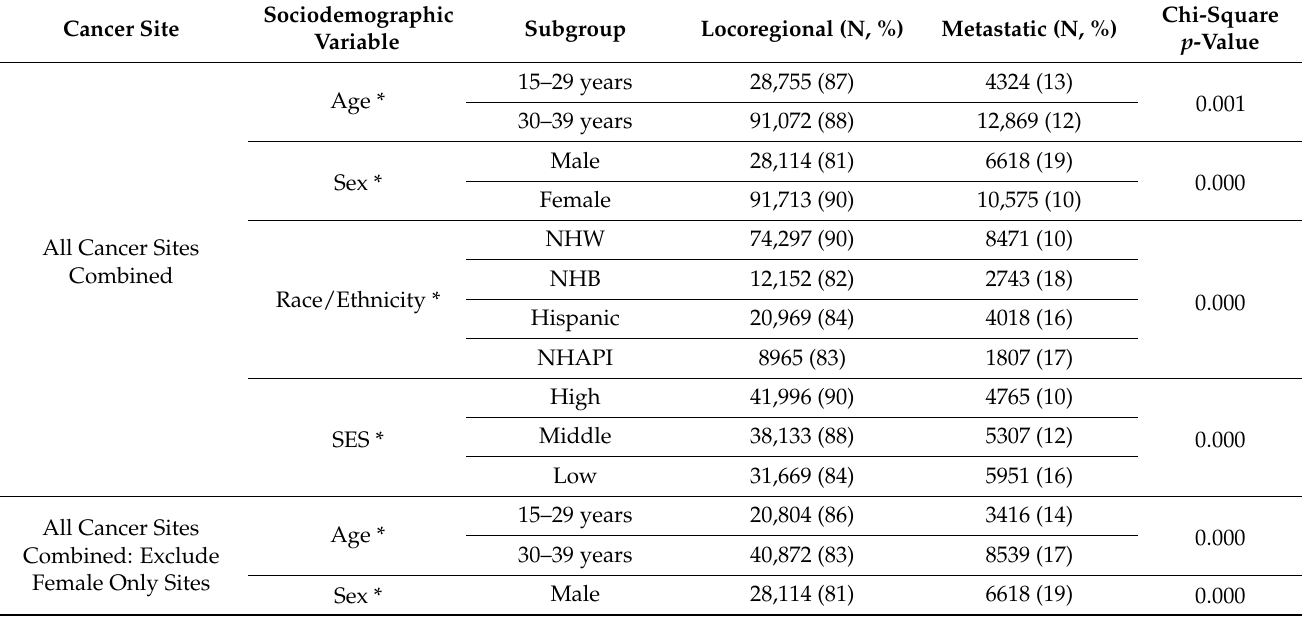
Table 1. Proportion of Metastatic Disease by Sociodemographic Subgroup: Surveillance, Epidemiol- ogy, and End Results Program